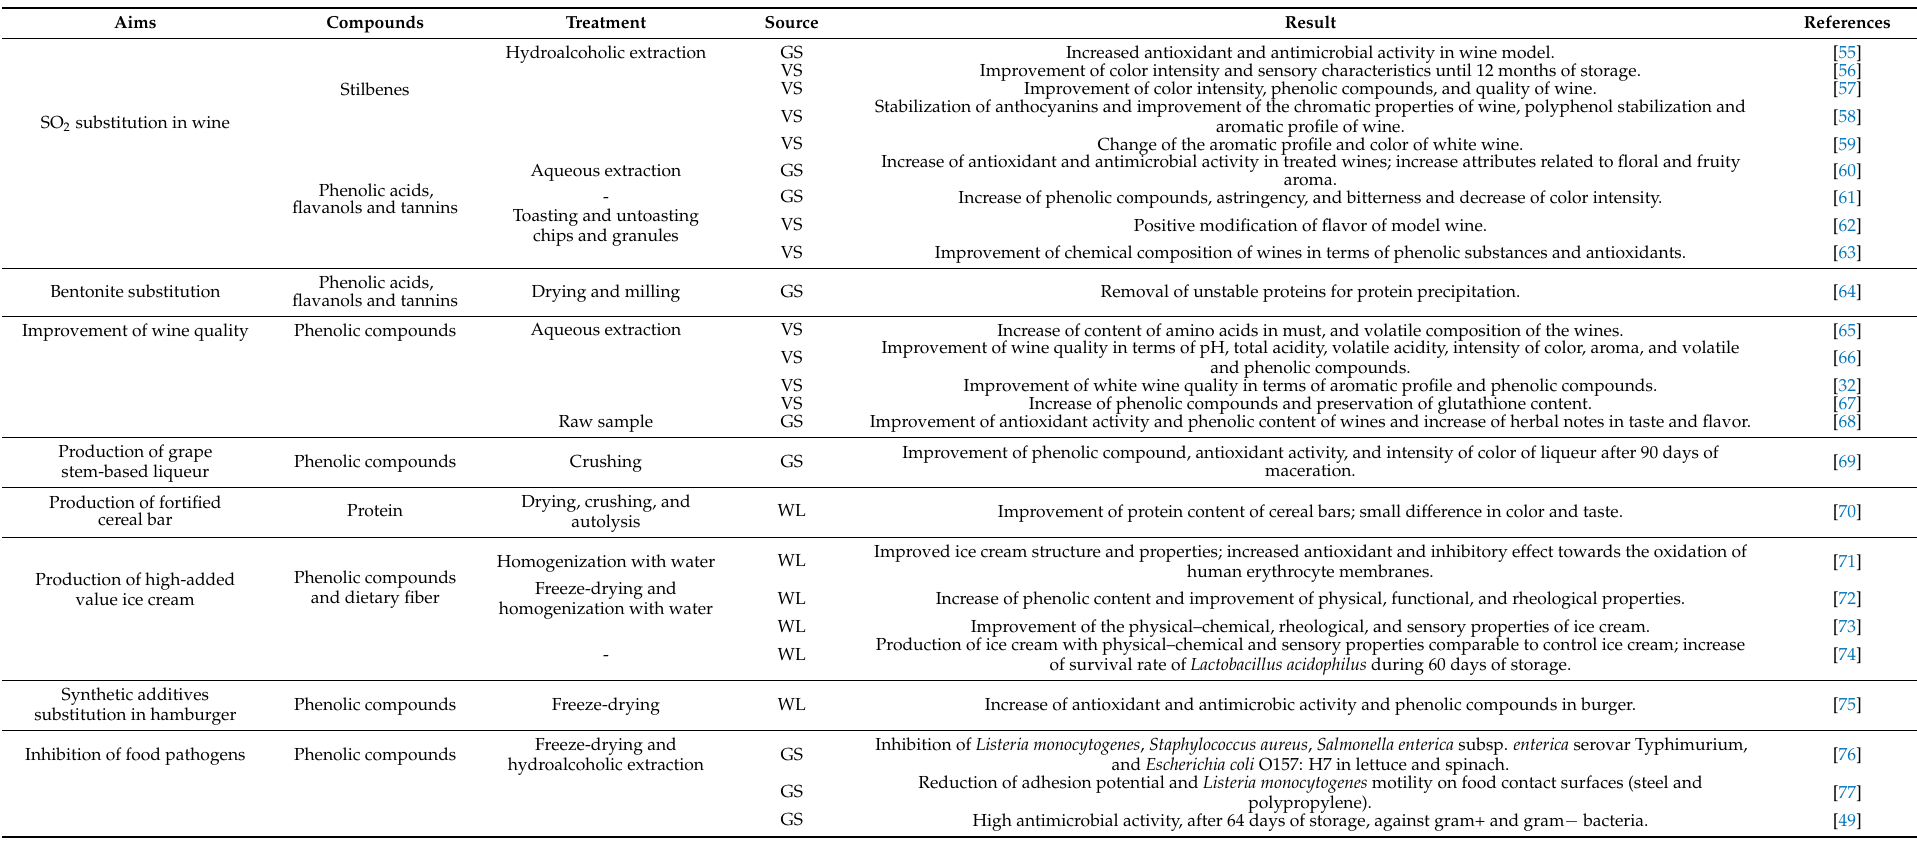
Table 1. Applications of vine shoots, grape stalks, and wine lees or their extracts in food and